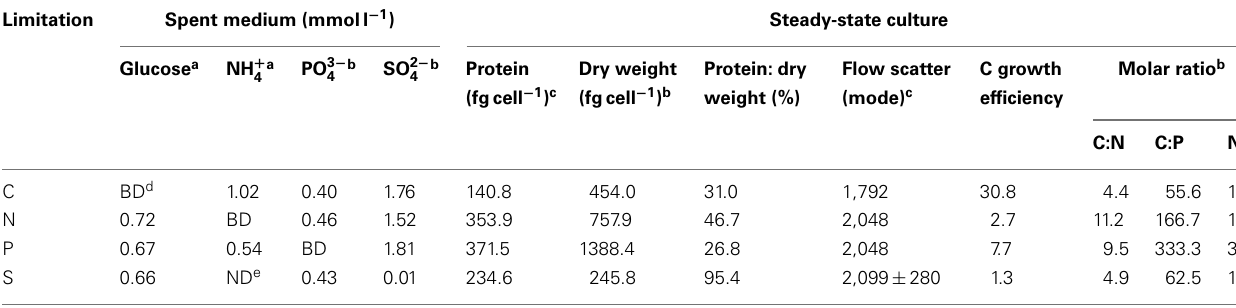
Table 1 | Biological and chemical status of R. pomeroyi DSS-3 chemostat cultures.